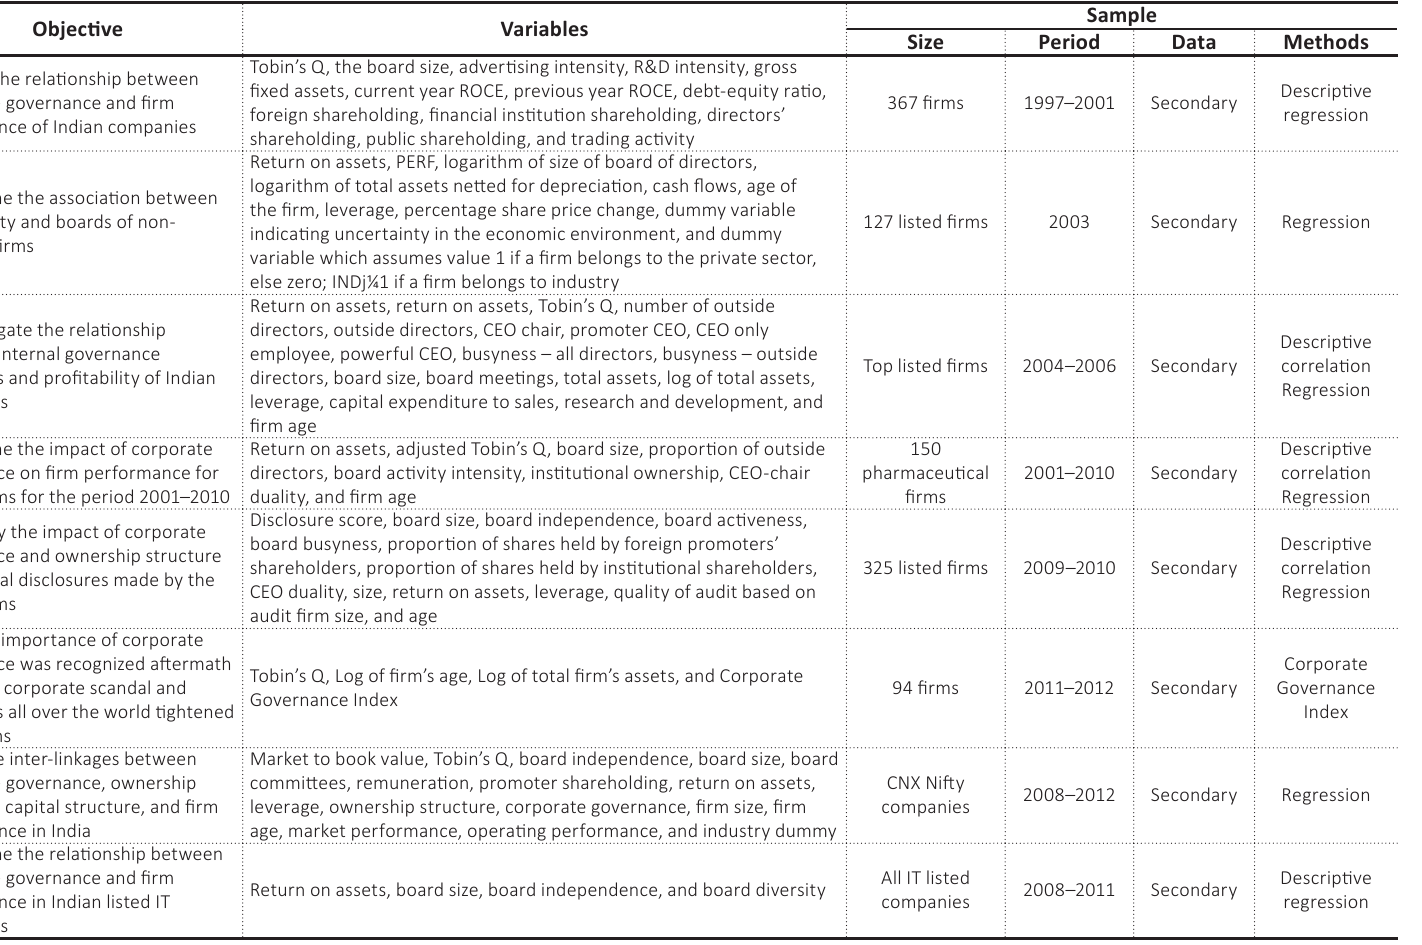
Table 1A. Some of prior studies in